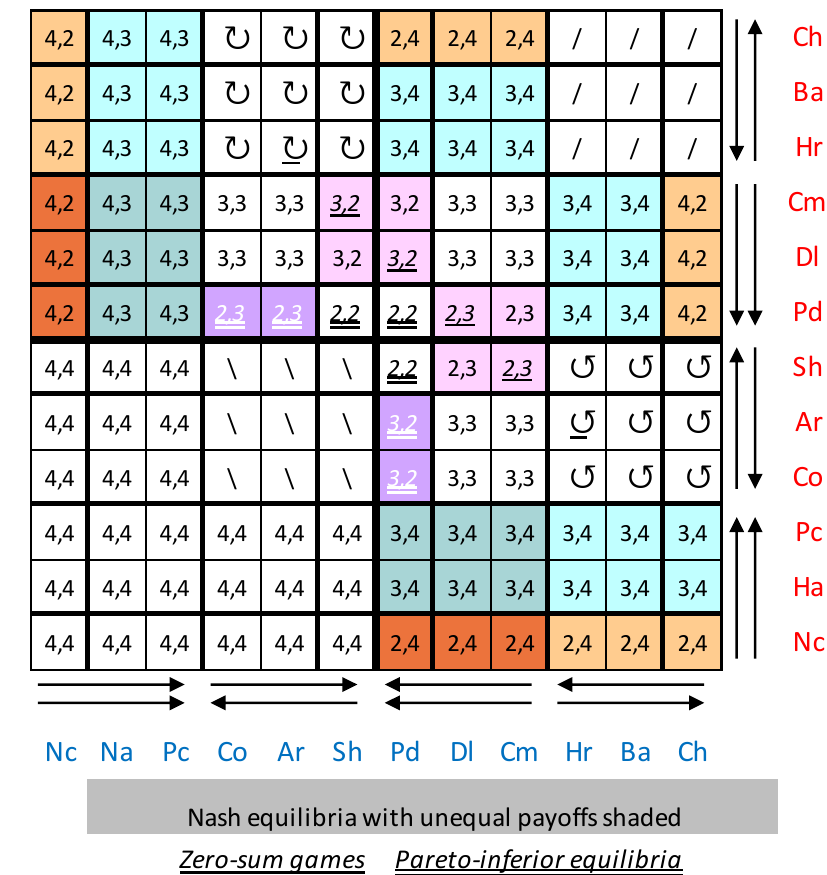
Nash equilibria with unequal payoffs